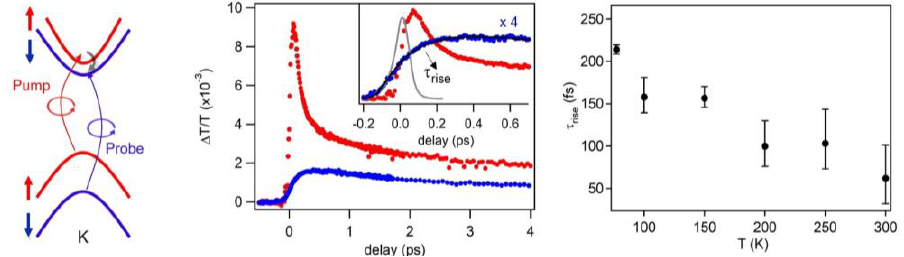
Fig. 1. (Left panel) Sketch of the band structure of 1L-WS 2 around the K point of the Brillouin zone. The pump and probe pulses have the same circular polarization. The pump is resonant with the A exciton while the probe is resonant with either the A (degenerate configuration) or B exciton (non- degenerate configuration). Only the non-degenerate configuration is sketched for sake of clarity. Only excitons in K point are excited because of the valley dependent optical selection rules for circular polarization. The intravalley scattering process (grey arrow) from upper to lower CB state causes the reduction of the absorption of the probe beam by Pauli blocking and results in a delayed formation of the bleaching signal around the B exciton. (Central panel) The red and blue curves are the  T/T signal measured in 1L-WS 2 at 77K around the A and B excitonic transitions, following excitation of the A transition. For degenerate pump and probe energies, the build-up dynamics is pulse-width limited, while the non-degenerate configuration displays a delayed formation. In the inset,  T/T around the B exciton peak is multiplied by 4 to highlight the finite build up time. The grey line is the cross correlation function between the pump and probe pulses. (Right panel) Temperature dependence of the B exciton rise time  rise